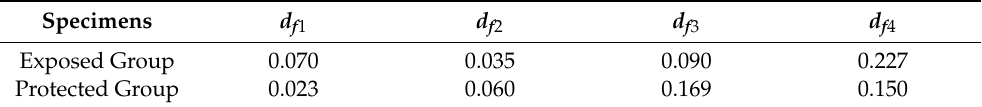
Table 5. Measured surface damage calculation